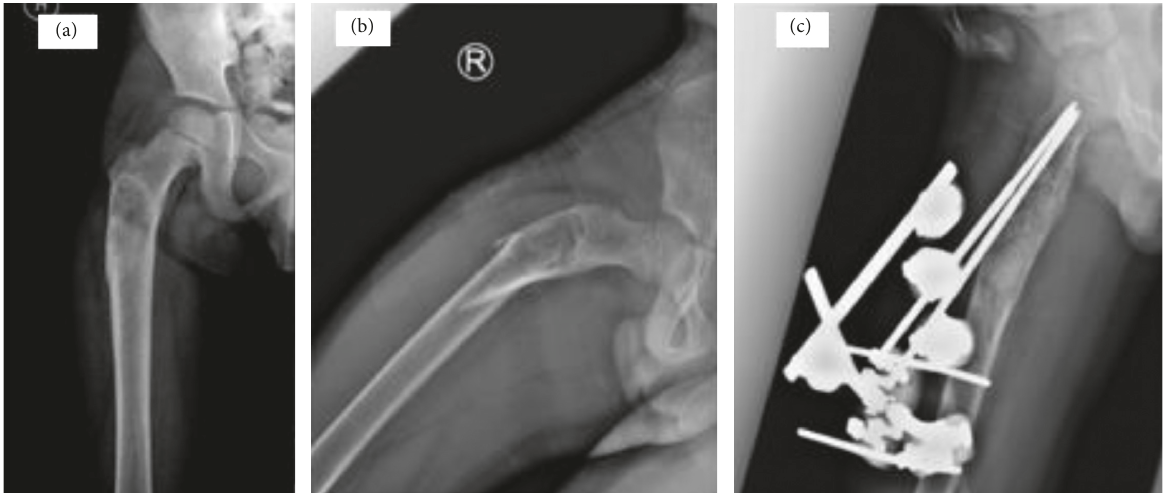
Figure 8: (a) AP Femur X-ray with proximal femur cyst diagnosed as benign fibrous histiocytoma. (b) The patient presented 2 years later with a pathological fracture. Final pathology revealed ABC. (c) Lateral X-ray of proximal femur with external fixator showing partial healing of the cyst and a well-maintained fracture reduction about 6 weeks after surgery. Table 1: Clinical and management features of the 7 recurrent ABC patients.